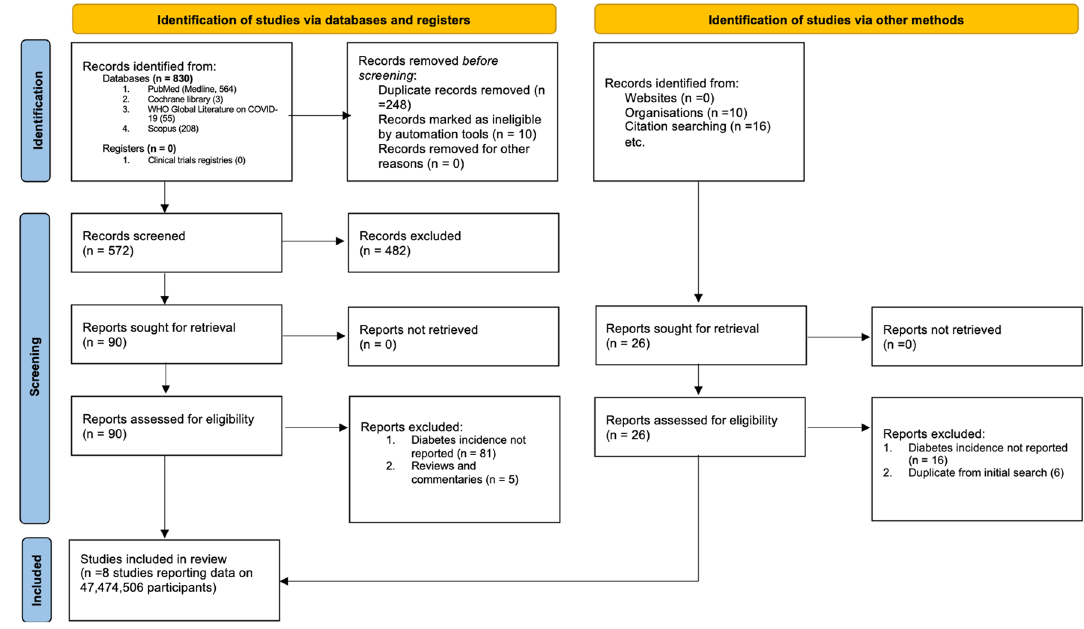
Figure 1. PRISMA flow chart of a systematic review of diabetes incidence in survivors of COVID-19. PRISMA, Preferred Reporting Items for Systematic Reviews and